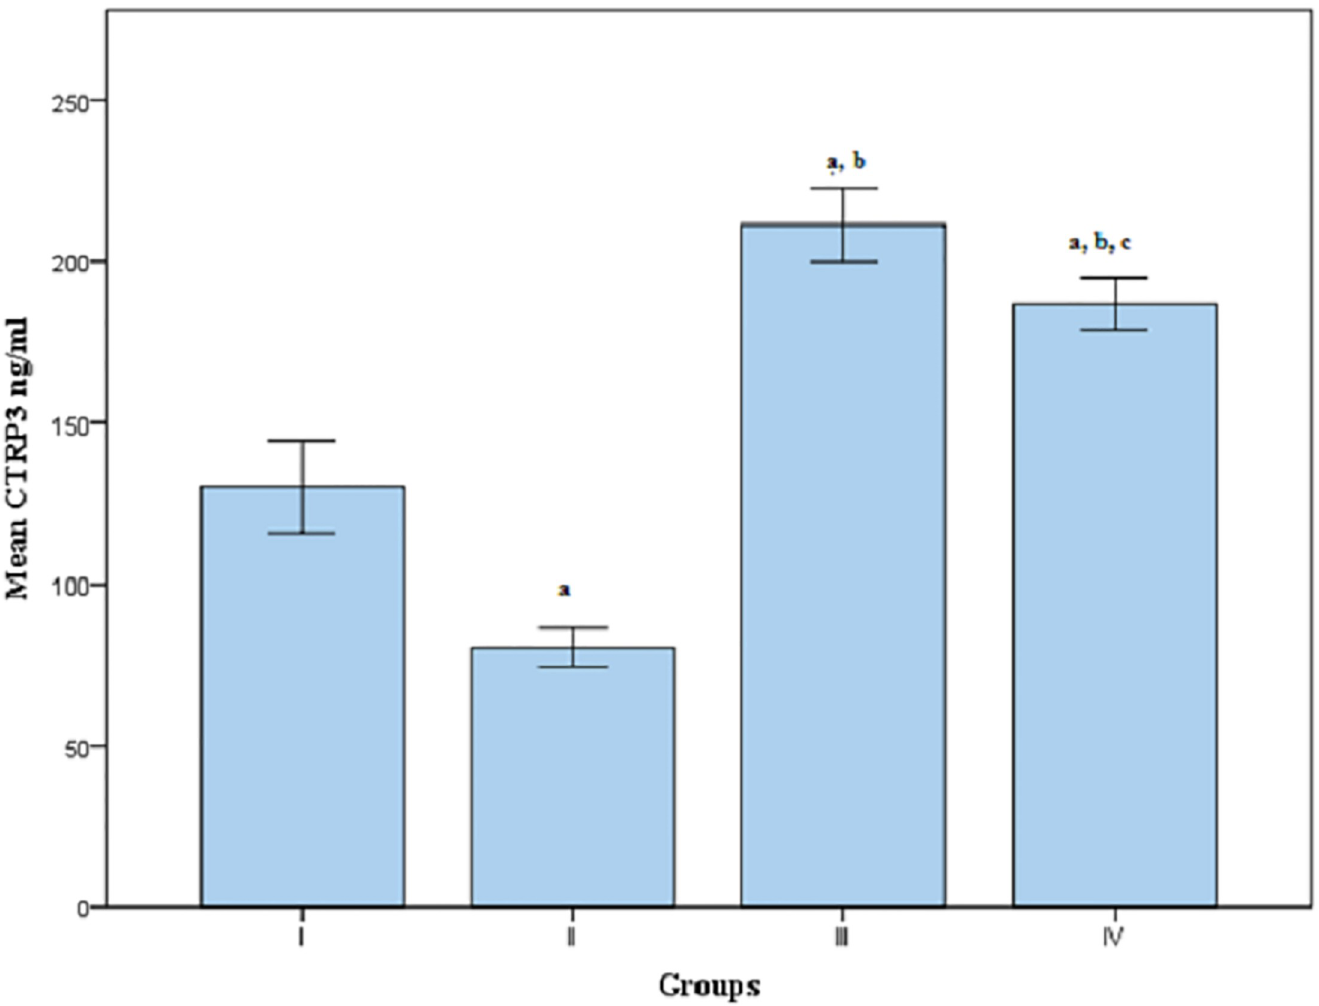
Fig 1. Mean serum CTRP3 levels in groups I, II, III and IV. Group(I):Apparent healthy control, Group(II):Patients with CAD, Group(III):Patients with T2DM, Group(IV):Patients with CAD secondary to T2DM, a: Significantly different from group I at p < 0.05, b: Significantly different from group II at p < 0.05, c: Significantly different from group III at p < 0.05, CTRP3: C1q complement/tumor necrosis factor (TNF)—related protein